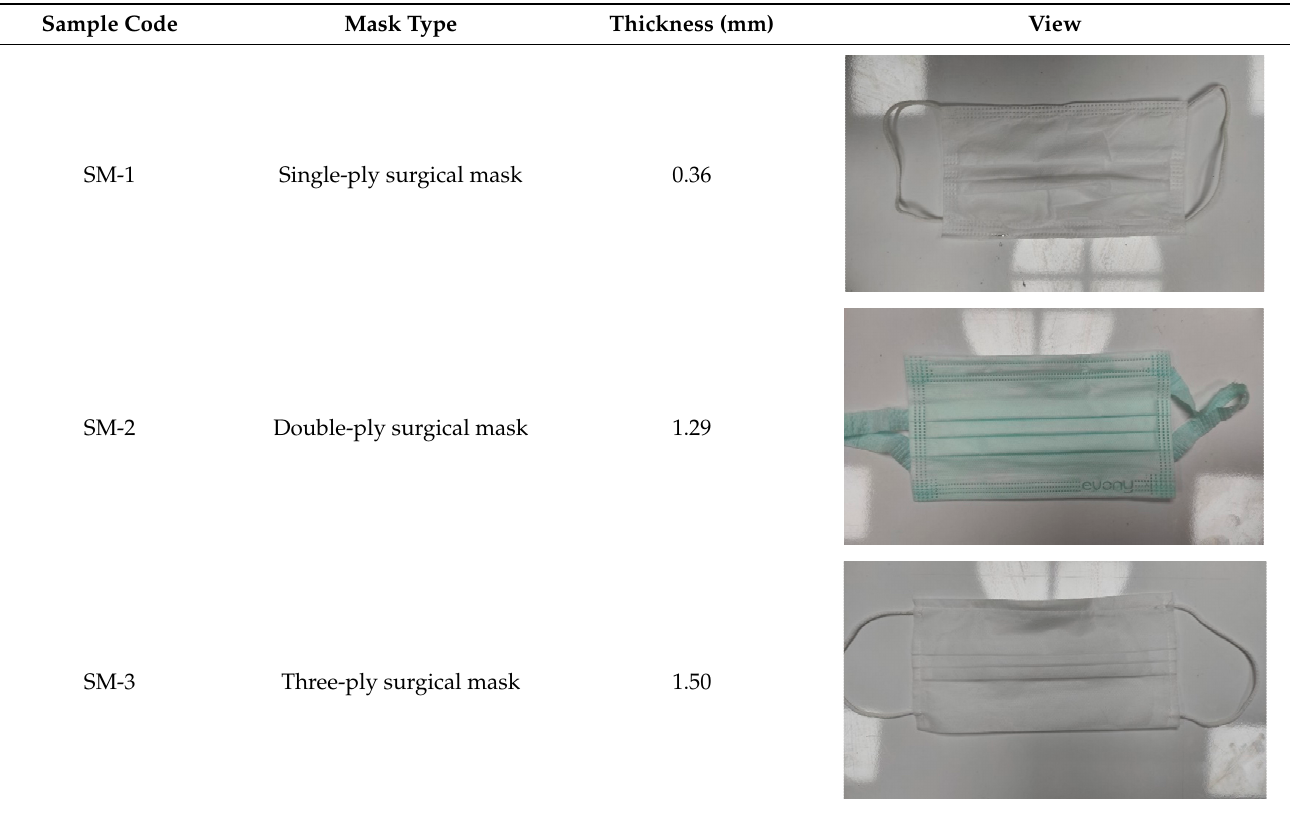
Table 1. Types of masks used in the study.